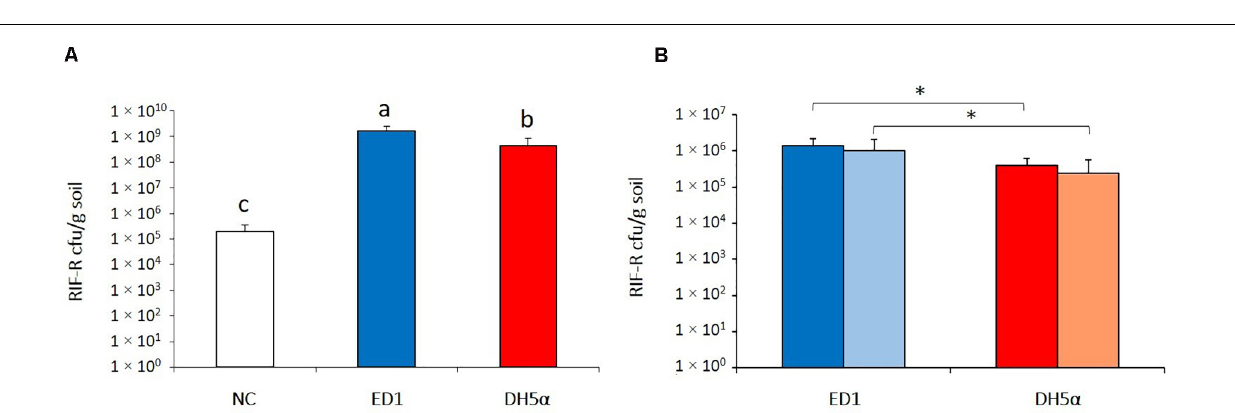
FIGURE 4 | Evaluation of E. coli strains ED1 and DH5 α rhizocompetence. (A) Bacterial abundance (cfu/g soil) of rifampicin-resistant bacteria in the lettuce rhizosphere after a 1-week colonization experiment performed with non-sterile soil. (B) Assessment of the stability of the rifampicin-resistant bacteria abundance in the rhizosphere of lettuce seedlings grown in sterile soil. Dark- and light-colored columns indicate cfu/g of soil 1 and 2 weeks after the bacterization, respectively. NC, non-bacterized lettuce seedlings; ED1/DH5 α , lettuce seedlings bacterized with ED1 and DH5 α strains, respectively. Different letters or asterisks indicate statistically significantly differences according to Student’s t -test ( p <